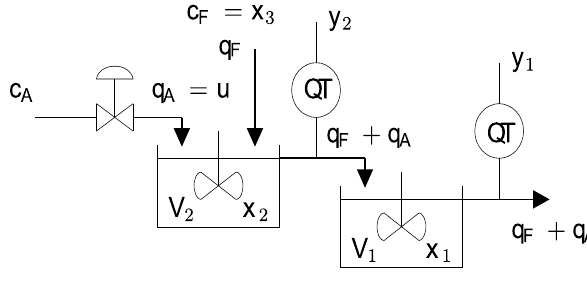
Figure 2: Two-stage stirred-tank mixing process in simula- tion